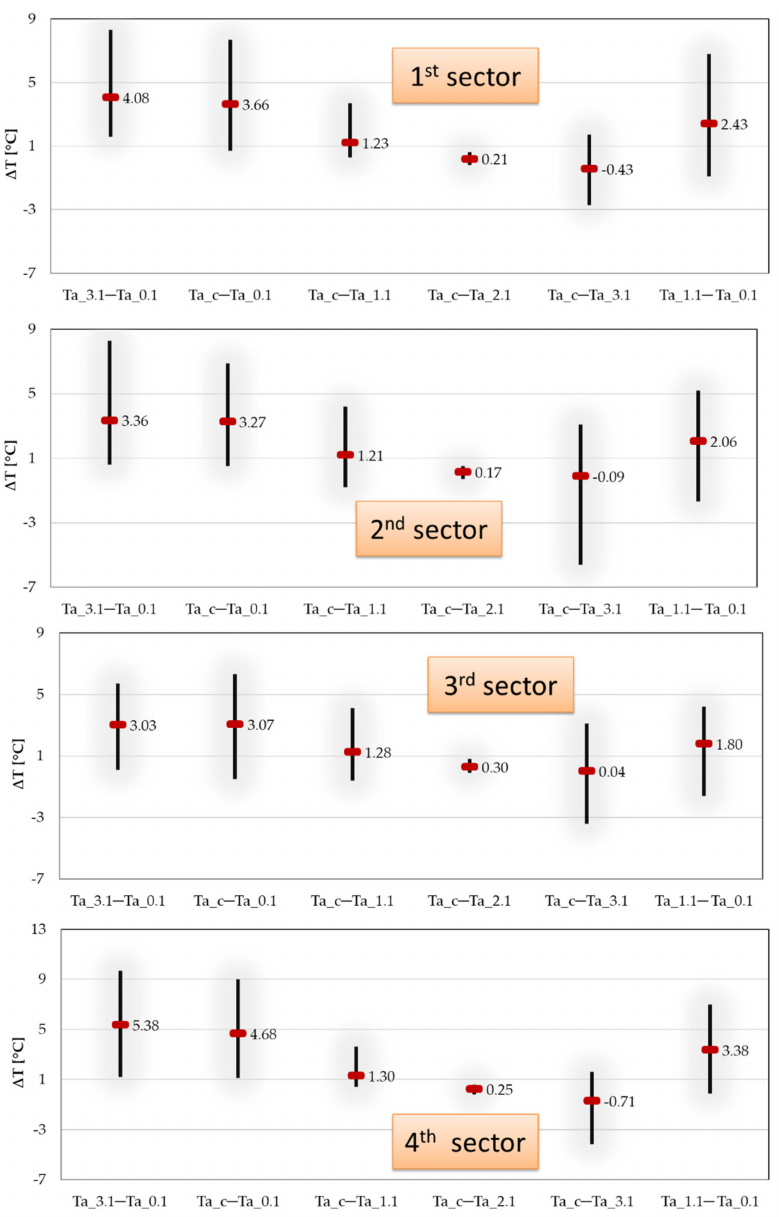
Figure 14. Extreme values for vertical temperature difference: fan coil